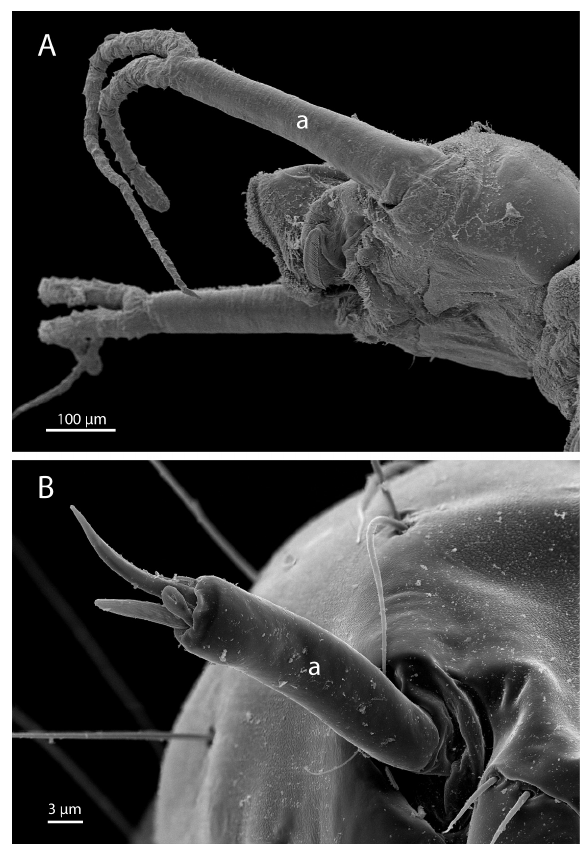
Figure 3 . Larval antenna, SEM images. A, Deuterophlebia colora- densis (Deuterophlebiidae), lateral. B, Nymphomyia dolichopeza (Nymphomyiidae), frontal. Abbreviation: a,